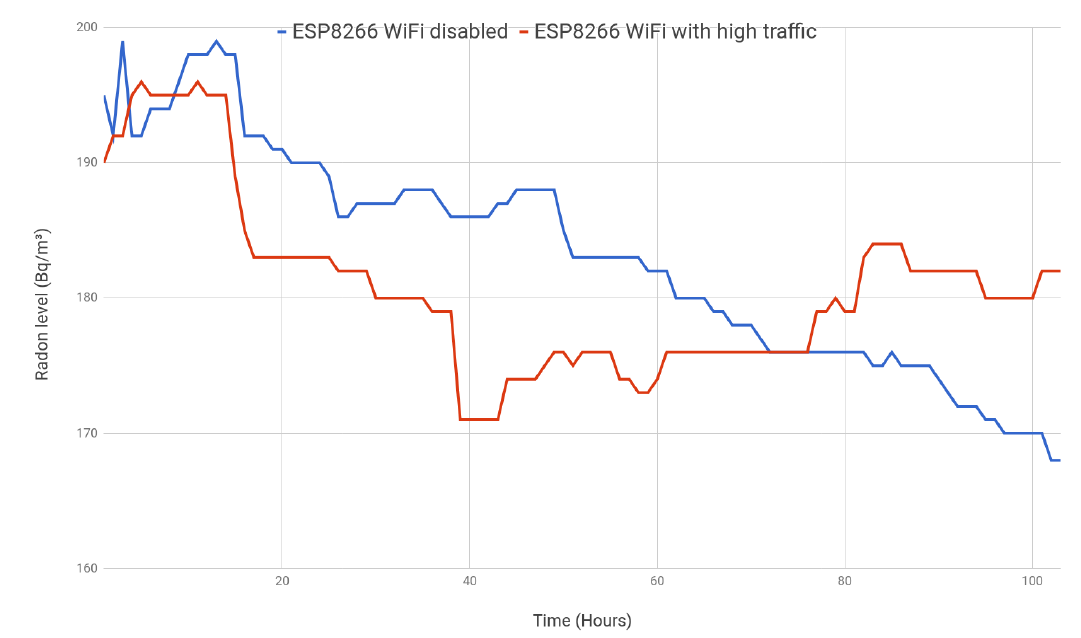
Figure 16. ESP8266 with WiFi disabled vs. ESP8266 with WiFi enabled and high